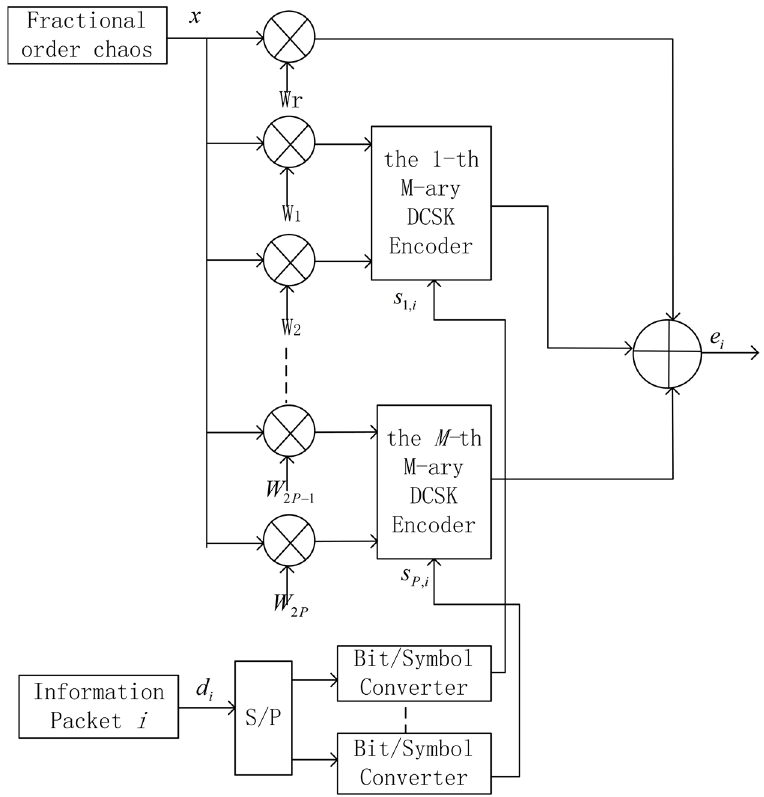
Figure 3. Block diagram of the MCS-MDCSK Modulation.